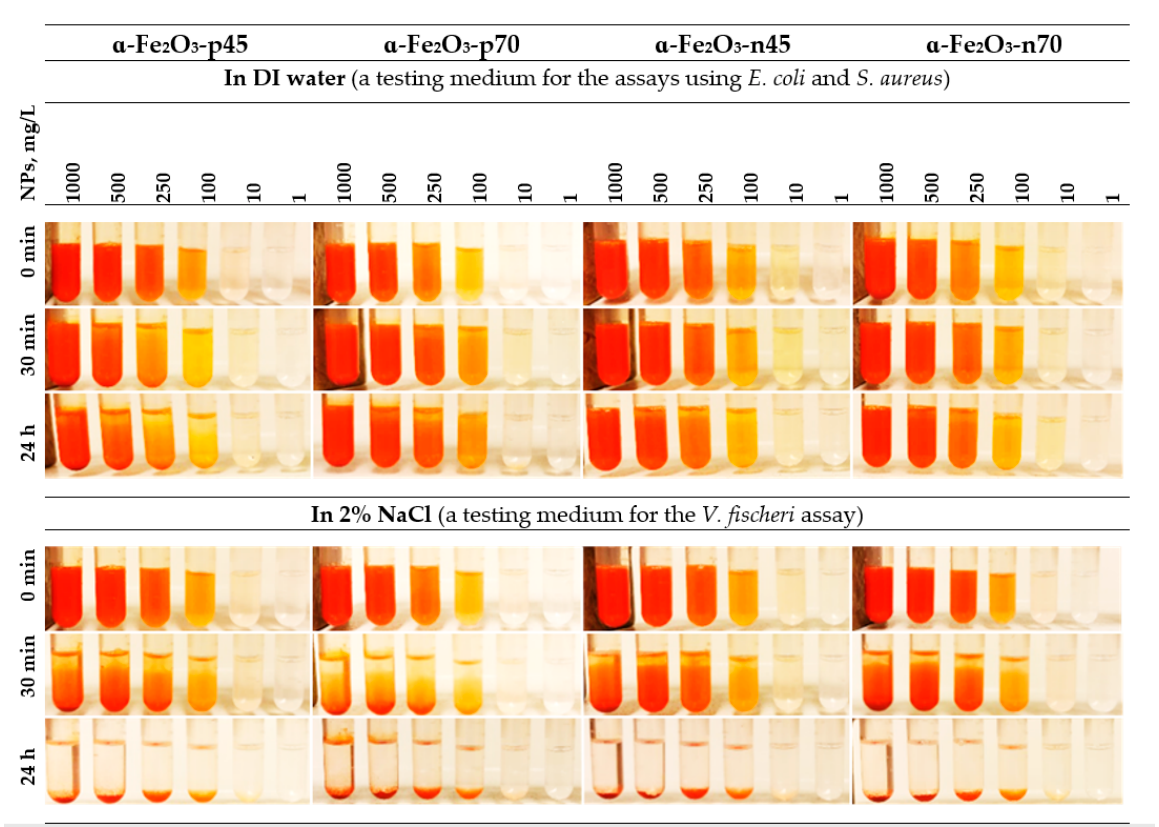
Figure 4. Visualization of stability of the α -Fe 2 O 3 NPs in DI water and 2% NaCl (see also Table 3).